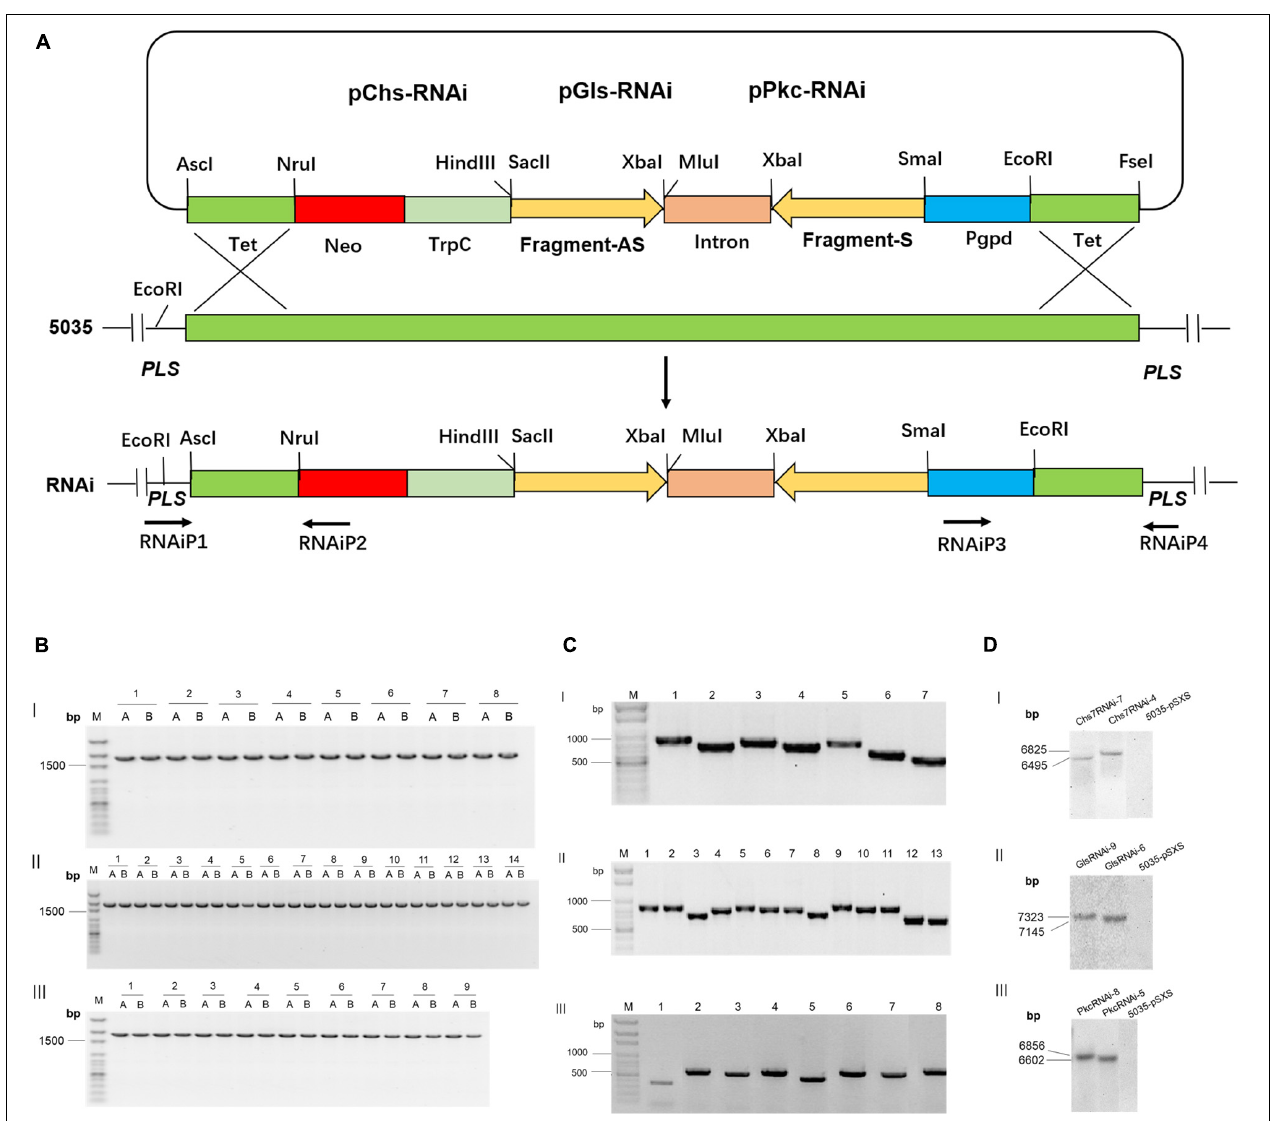
FIGURE 1 | Integration of Chs7RNAi, GlsRNAi and PkcRNAi constructs into Fusarium graminearum genome and PCR and Southern blot analyses of transformants. (A) A schematic diagram for homologous recombination between the replacement vectors pRNAi series (Chs7RNAi, GlsRNAi and PkcRNAi) and the PLS gene locus of F. graminearum strain 5035-pSXS-Neo-Tet. (B) PCR analyses of transgenic F. graminearum strains carrying Chs7RNAi, GlsRNAi, PkcRNAi and 5035-pSXS-Neo-Tet constructs. Four strains from each transformation were randomly selected for analysis (here only one strain from each transformation is shown as an example). PCR products from the 5 (cid:48) and 3 (cid:48) regions of the disrupted PLS gene were amplified with the primers RNAiP1/RNAiP2 and RNAiP3/RNAiP4, respectively. The 1752 − and 1777-bp fragments for Chs7 and pSXSH-Neo-Tet (B-I, lane1-7 and lane 8), Gls and pSXSH-Neo-Tet (B-II, lane1-13 and lane 14) and Pkc and pSXSH-Neo-Tet (B-III lane1-8 and lane 9) were amplified from the 5 (cid:48) and 3 (cid:48) regions of the disrupted PLS gene. M: 100 bp DNA Marker; A: PCR products from the 5 (cid:48) regions of the disrupted PLS gene; B: PCR products from the 3 (cid:48) regions of the disrupted gene. (C) Construct sequence-specific PCR. To amplify seven Chs7RNAi construct sequences, seven pairs of primers Chs7SF1/intronP2, Chs7SF2/intronP2, Chs7SF3/intronP2, Chs7SF4/intronP2, Chs7SF5/intronP2, Chs7SF6/intronP2, and Chs7SF7/intronP2 were used, generating seven products of 759 bp (Chs7-1), 695 bp (Chs7-2), 711 bp (Chs7-3), 685 bp (Chs7-4), 713 bp (Chs7-5), 592 bp (Chs7-6), and 520 bp (Chs7-7), respectively. For PCR of Gls construct sequences, 13 pairs of primers GLSF1/intronP2, GLSF2/intronP2, GLSF3/intronP2, GLSF4/intronP2, GLSF5/intronP2, GLSF6/intronP2, GLSF7/intronP2, GLSF8/intronP2, GLSF9/intronP2, GLSF10/intronP2, GLSF11/intronP2, GLSF12/intronP2, GLSF13/intronP2 were used to generate 13 PCR products of 759 bp (Gls-1), 785 bp(Gls-2), 699 bp (Gls-3), 718 bp (Gls-4), 756 bp (Gls-5), 739 bp (Gls-6), 707 bp (Gls-7), 704 bp (Gls-8), 828 bp (Gls-9), 721 bp (Gls-10), 725 bp (Gls-11), 656 bp (Gls-12), and 578 bp (Gls-13), respectively. Similarly, eight PCR primer pairs for PkcRNAi were used to generate eight specific products of 448 bp (Pkc-1), 698 bp (Pkc-2), 630 bp (Pkc-3), 723 bp (Pkc-4), 562 bp (Pkc-5), 696 bp (Pkc-6), 666 bp (Pkc-7), 689 bp (Pkc-8), respectively. All these PCR products have the sizes as expected. (D) Southern blot analyses of selected transgenic F. graminearum strains carrying Chs7-, Gls- and PkcRNAi constructs. The genome DNA isolated from strains 5035-pSXS-Neo-tet, Chs7RNAi-4, Chs7RNAi-7, GlsRNAi-6, GlsRNAi-9, PkcRNAi-5 and PkcRNAi-8 were digested with Eco RI and hybridized with a fragment of a kanamycin resistance gene amplified with the primers KamP1/KamP2. The sizes of hybridization fragments for the strains Chs7RNAi-4, Chs7RNAi-7, GlsRNAi-6, GlsRNAi-9, PkcRNAi-5 and PkcRNAi-8 were 6825 bp, 6495 bp, 7145 bp, 7323 bp, 6602 bp, and 6856 bp, respectively, as expected.